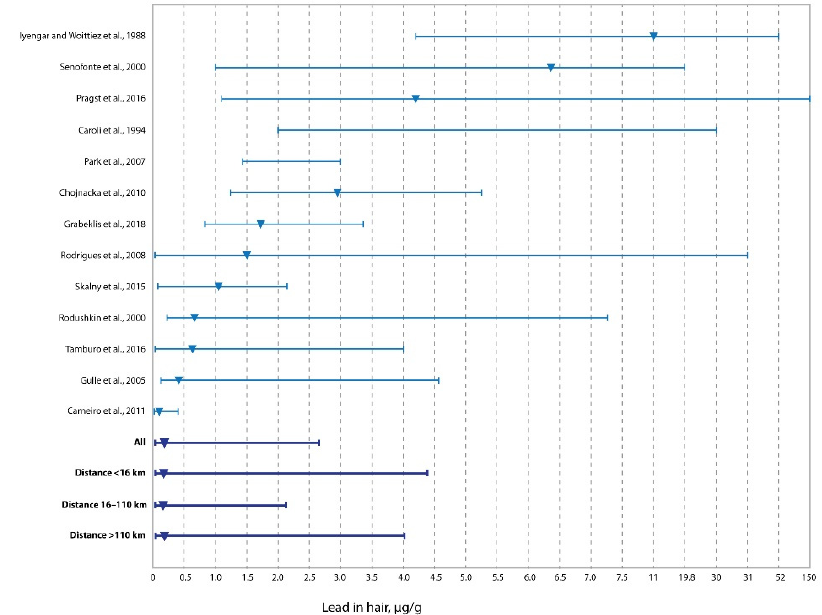
Figure 2. Concentrations of lead in the hair of residents living at different distances from oil and gas production fields vs. literature data (medians and ranges) [13, 29, 48–58].